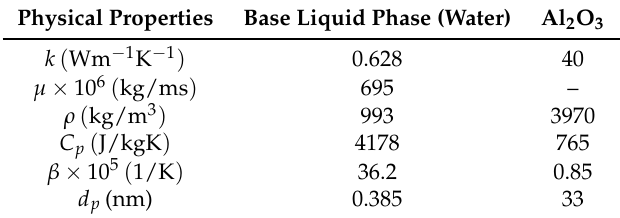
Table 1. Thermophysical properties of base liquid with Al 2 O 3 nanoparticles at T = 310 K